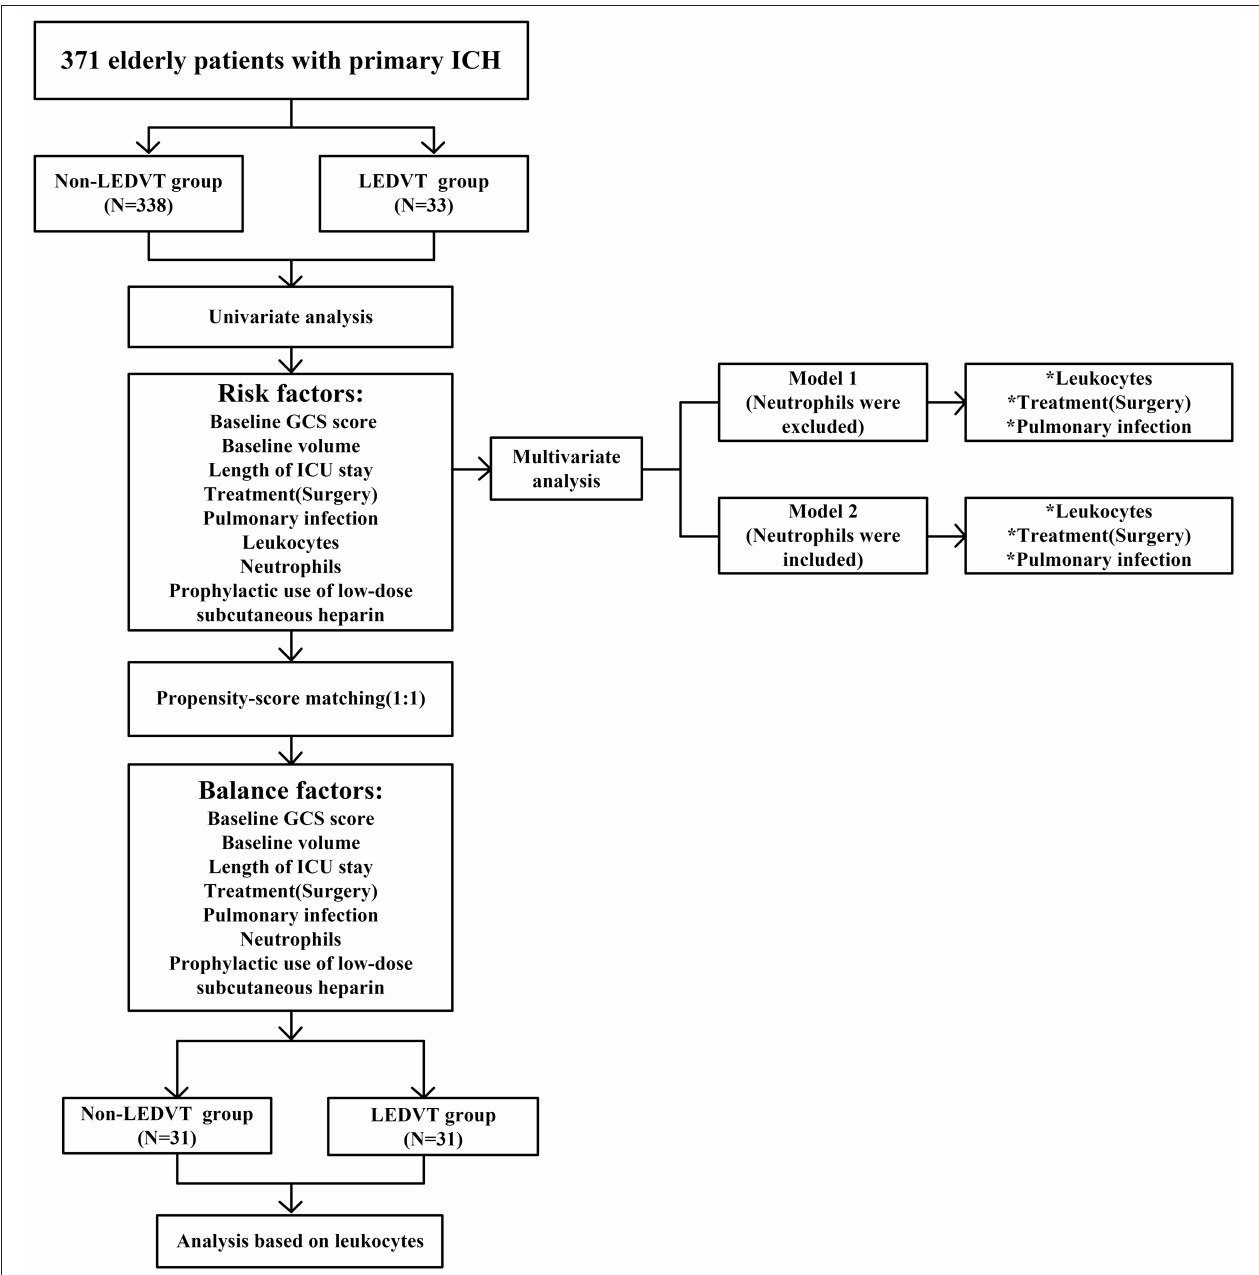
FIGURE 1 | Flowchart of the study. LEDVT, lower-extremity deep venous thrombosis; GCS, Glasgow Coma Scale; ICH, intracerebral hemorrhage; ICU, intensive care unit. * p < 0.05.